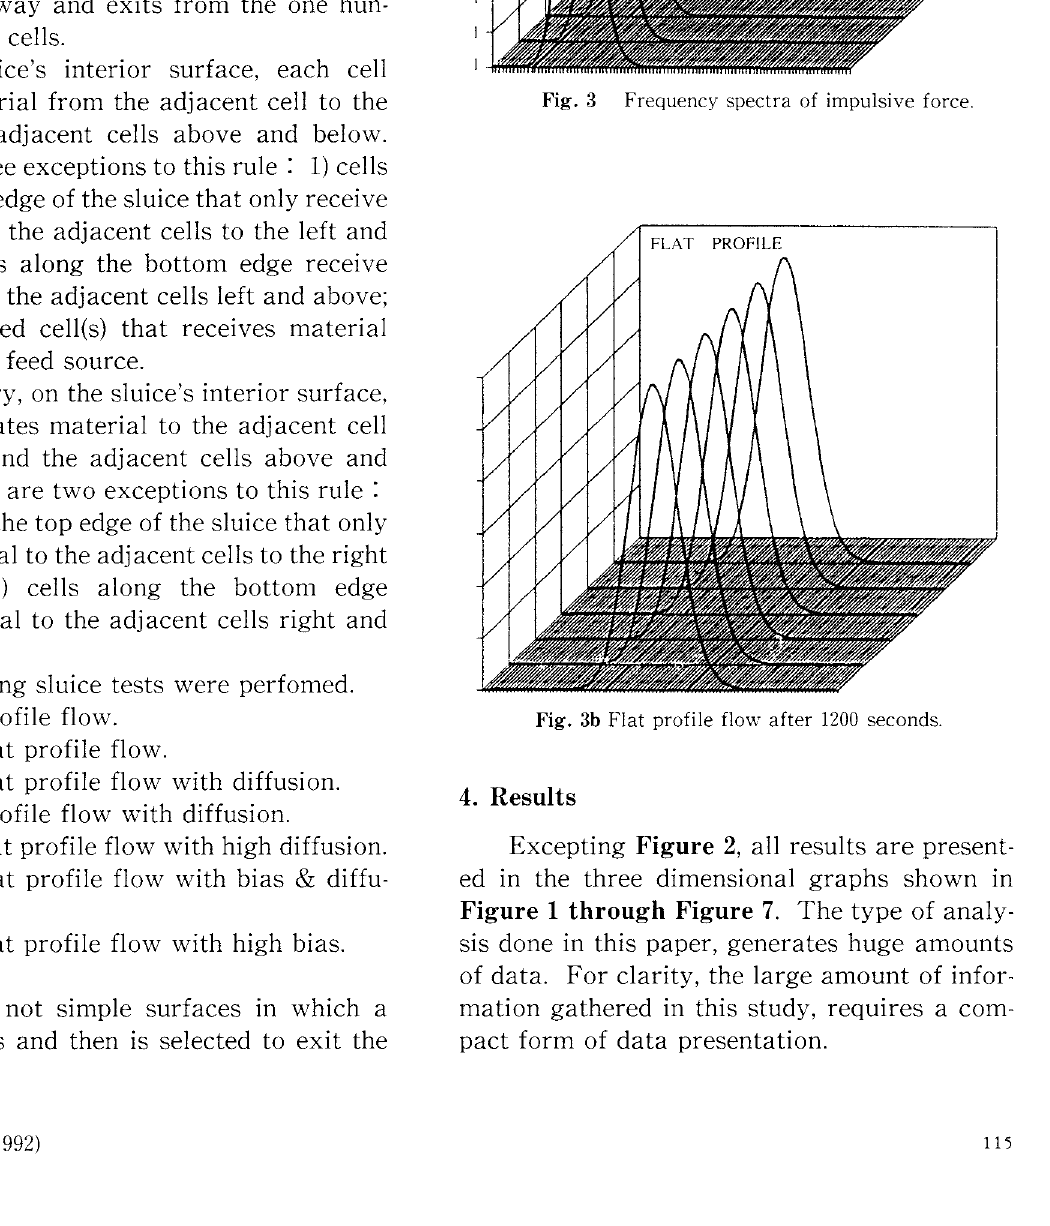
Frequency spectra of impulsive force.